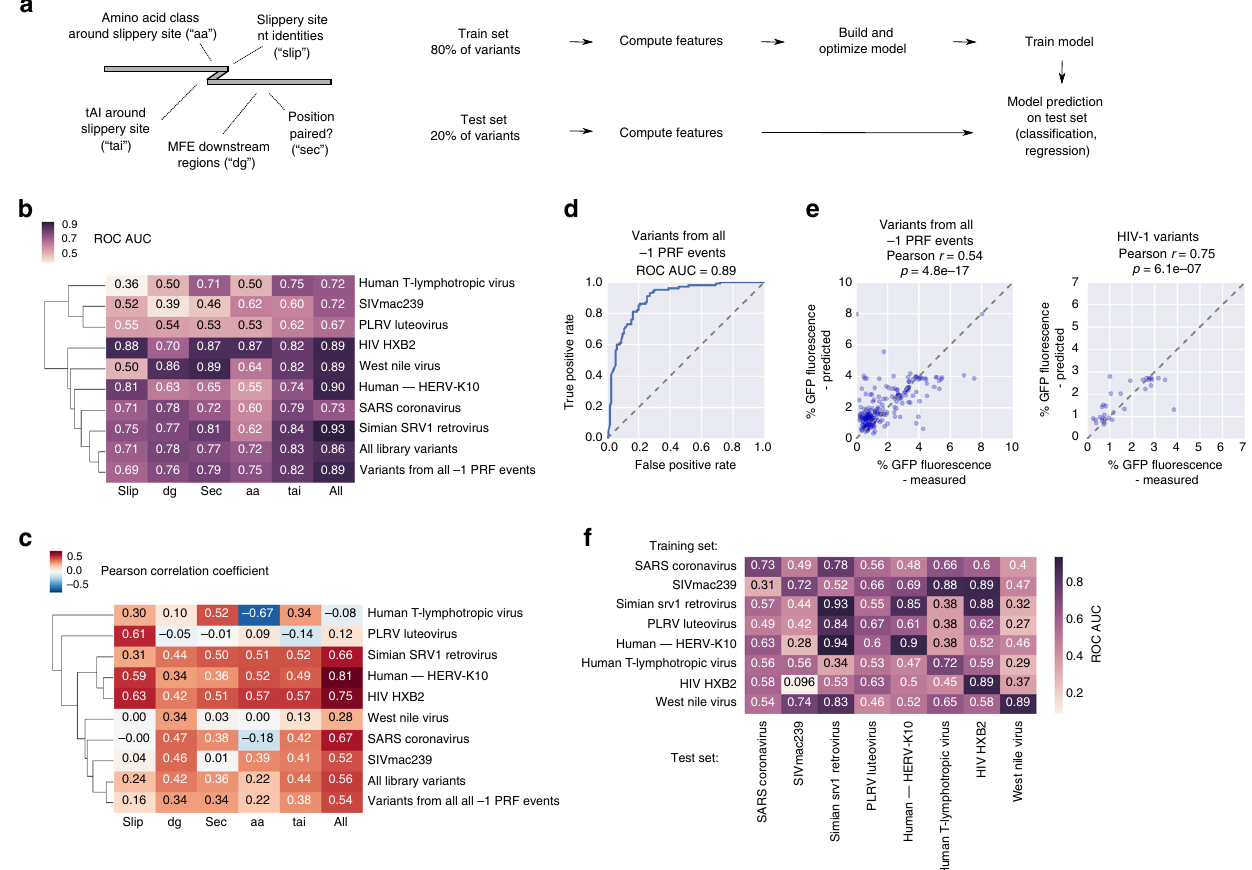
Fig. 6 Prediction of frameshifting potential and ef fi ciency. a Outline of the process of generating features and building and testing predictive models. b , c Prediction scores (area under the receiver operating characteristic curve (ROC AUC) in the case of classi fi cation ( b ) and Pearson correlation coef fi cients in the case of regression ( c )) on held-out test data for the indicated PRF event(s) or the entire library using different feature sets (slip: nucleotide identities in the canonical XXXYYYZ slippery site; tai: tAI scores around the slippery site, aa: amino acid class (unpolar, polar, and charged) around the slippery site, dg: MFE of downstream regions, sec: predicted pairedness of downstream positions). d ROC curve showing performance of a classi fi er trained on 80% of all designed library variants passing fi ltering and testing on the remaining 20%. e For the test set (20% of all designed library variants of all − 1 PRF events (left) or HIV-1 (right) passing fi ltering), the measured % GFP fl uorescence is plotted against the model prediction (trained on 80% of all library variants of all − 1 PRF events (left) or HIV-1 (right) passing fi ltering); Pearson correlation coef fi cient and the associated two-tailed p -value are reported. f Prediction scores (ROC AUC) on held-out test data (20%) for the indicated PRF event (columns) using the full set of features and training the model on the training data (80%) from the indicated PRF event